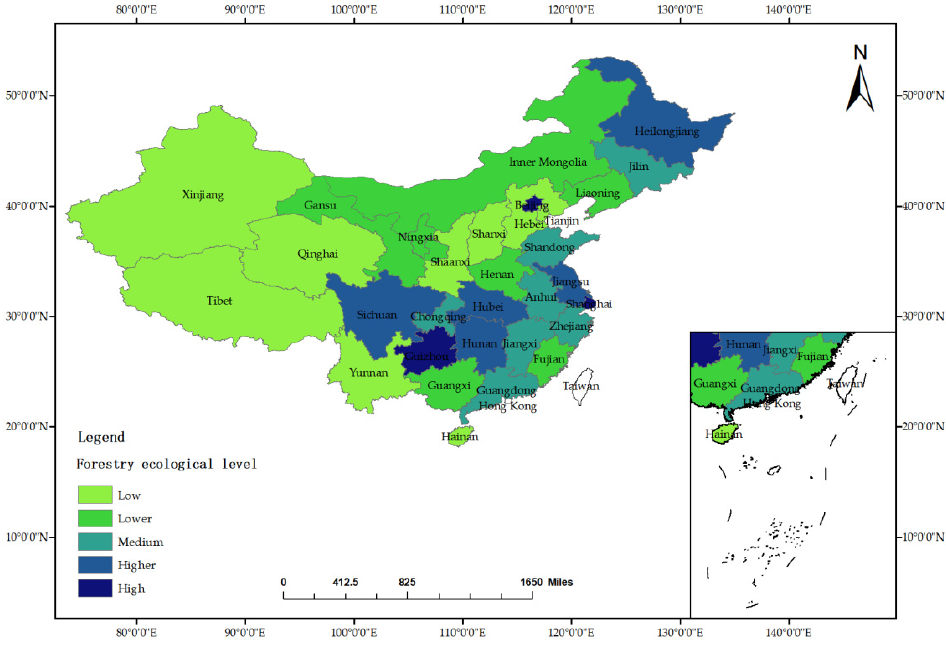
Figure 7. Distribution of the coordination degree in 2018.